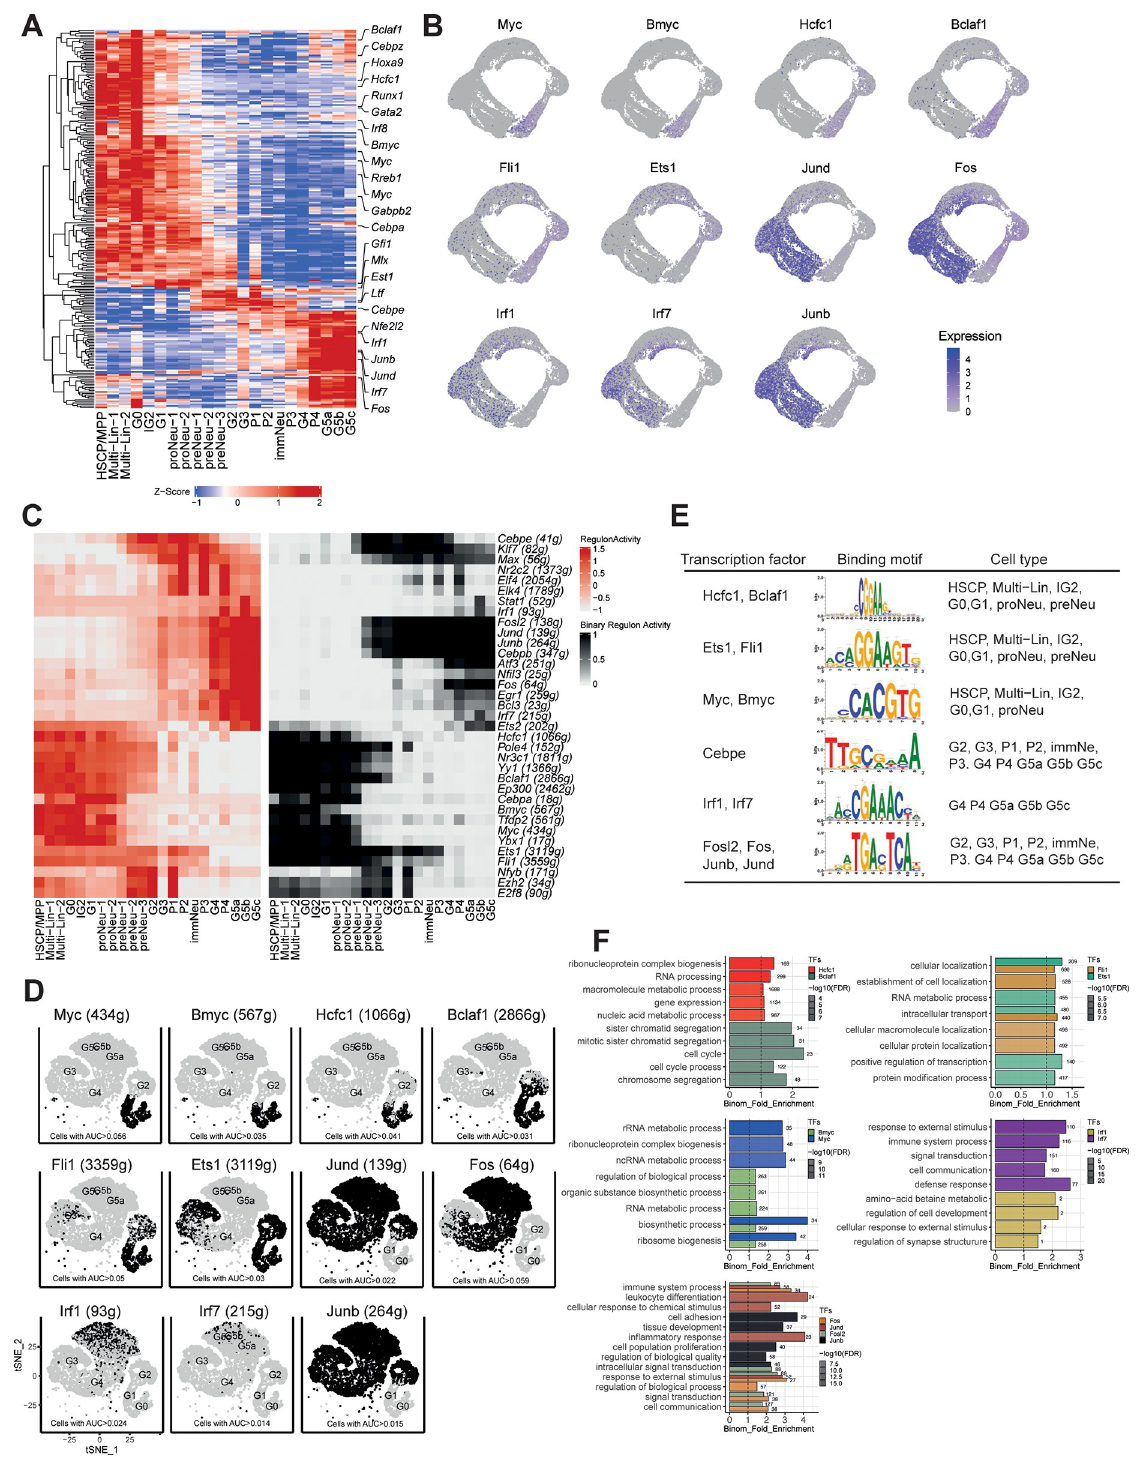
Fig 2. Transcription factor networks of neutrophils along differentiation trajectories. (A) Heatmap showing the expression of TFs across scRNA-seq-defined neutrophil subpopulations. (B) Expression of differentiation-related TFs. (C) SCENIC results for neutrophil transcriptional regulatory networks. Heatmap showing the expressed and active transcription factors in each cell class. The AUCell and BINary regulon activity of the transcription factors in each cell class are indicated as red (highly active) and white (lowly active), and black (active) and white (inactive), respectively. (D) The t-SNE presentation of key regulons in each scRNA-seq-defined neutrophil subpopulation.